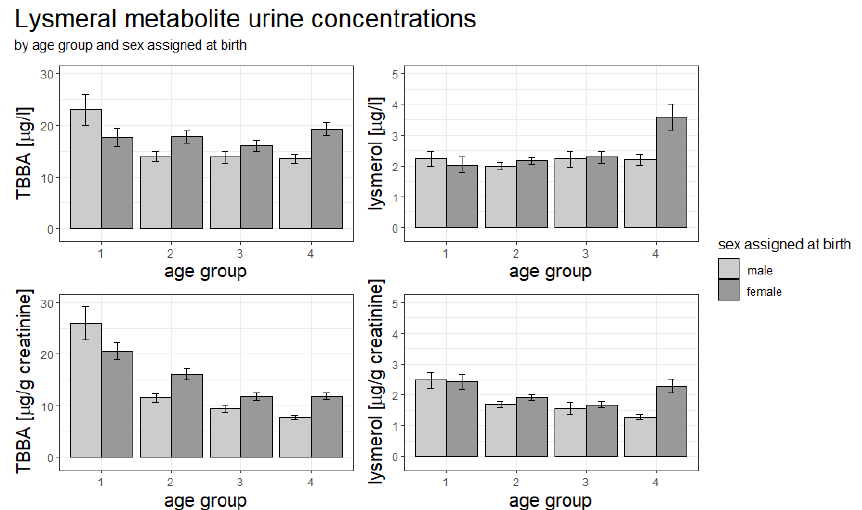
Figure 3. Concentrations of lysmeral metabolites tert-butylbenzoic acid (TBBA) and lysmerol, both volume-based and creatinine-adjusted, grouped by age group and sex assigned at birth. Bars represent standard deviations. Age groups are 3 – 5 years (1), 6 – 10 years (2), 11 – 13 years (3) and 14 – 17 years (4).